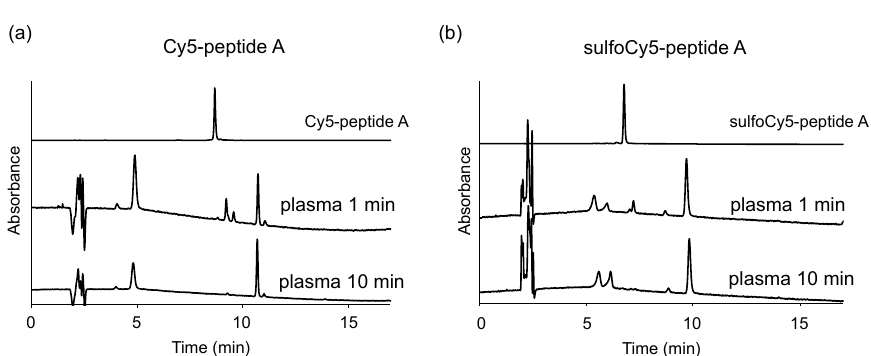
Figure 7. The time course of the concentration of Cy5/sulfoCy5-peptide A in mouse plasma. The data represent the mean ± SEM ( n = 3). 11. Figure 8 should be updated as: